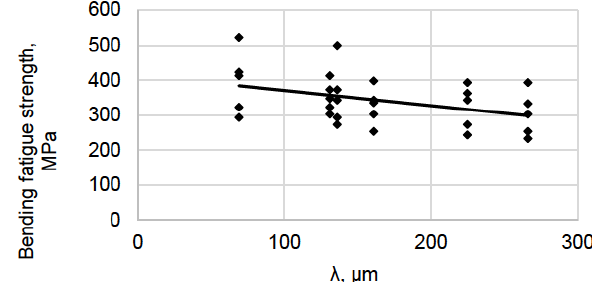
Figure 6: Bending fatigue strength of steel hardened and tempered at 200, 300, 400, 500 and 600 ∘ C subject to impurities space